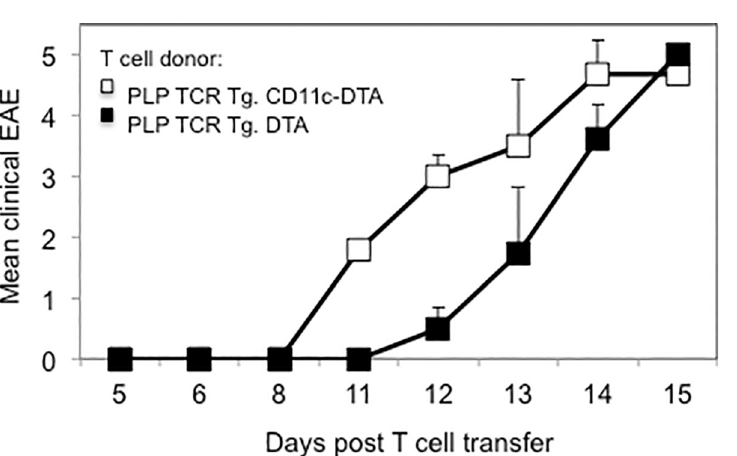
Fig 3. CD4 + T cells from PLP TCR Tg. CD11c-DTA SJL mice mediate severe EAE in Rag2-/- SJL recipient mice. Column purified CD4 + T cells from na ï ve PLP TCR Tg. CD11c-DTA SJL mice or PLP TCR Tg. DTA control mice were adoptively transferred into Rag2 -/- SJL recipient mice (n = 4–5 mice/group). Clinical signs of EAE were assessed daily in recipient mice for the indicate time and are shown as mean clinical EAE ± SEM. https://doi.org/10.1371/journal.pone.0250340.g003 PLOS ONE | https://doi.org/10.1371/journal.pone.0250340 April 23,